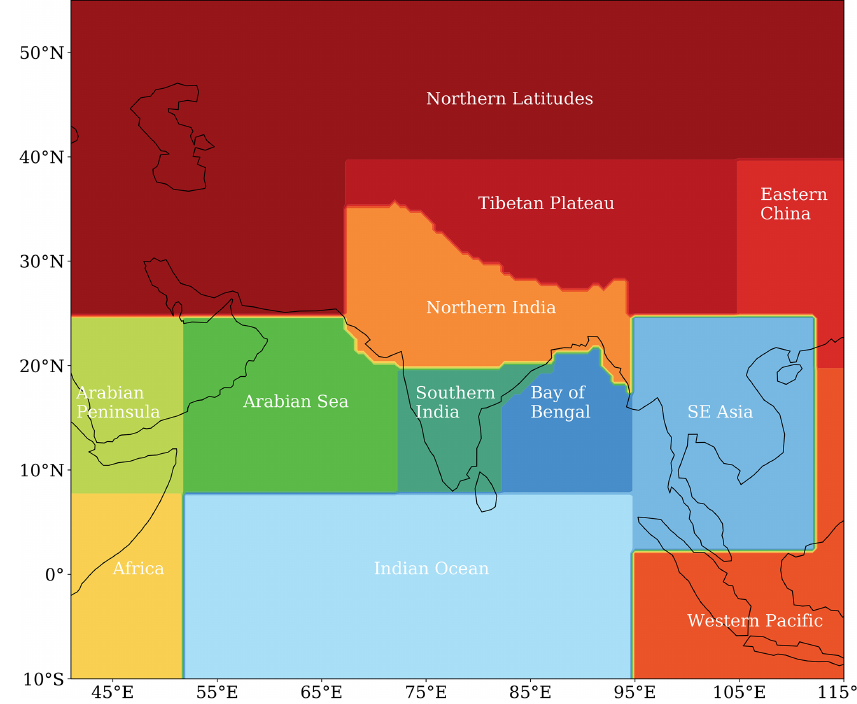
Figure 1. The boundaries of the study area and the subdivisions of the areas used for the regional analysis.